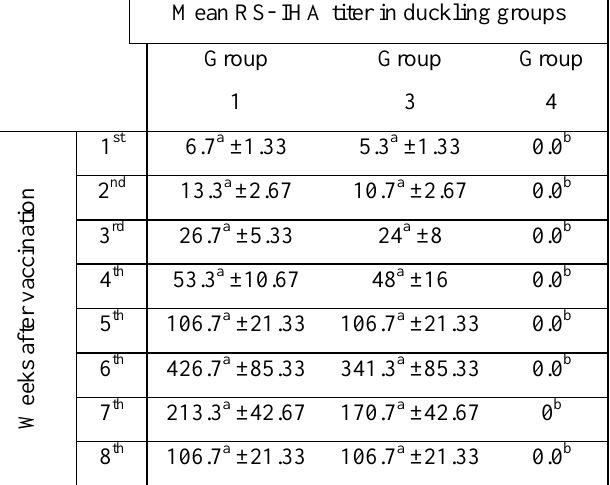
Group 1:vaccinated with the single Riemerella